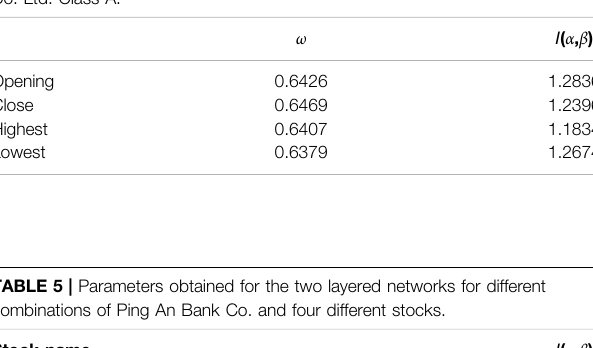
TABLE4| ParametersobtainedforthepricedataforPingAnBankCo.andVanke Co. Ltd. Class A.